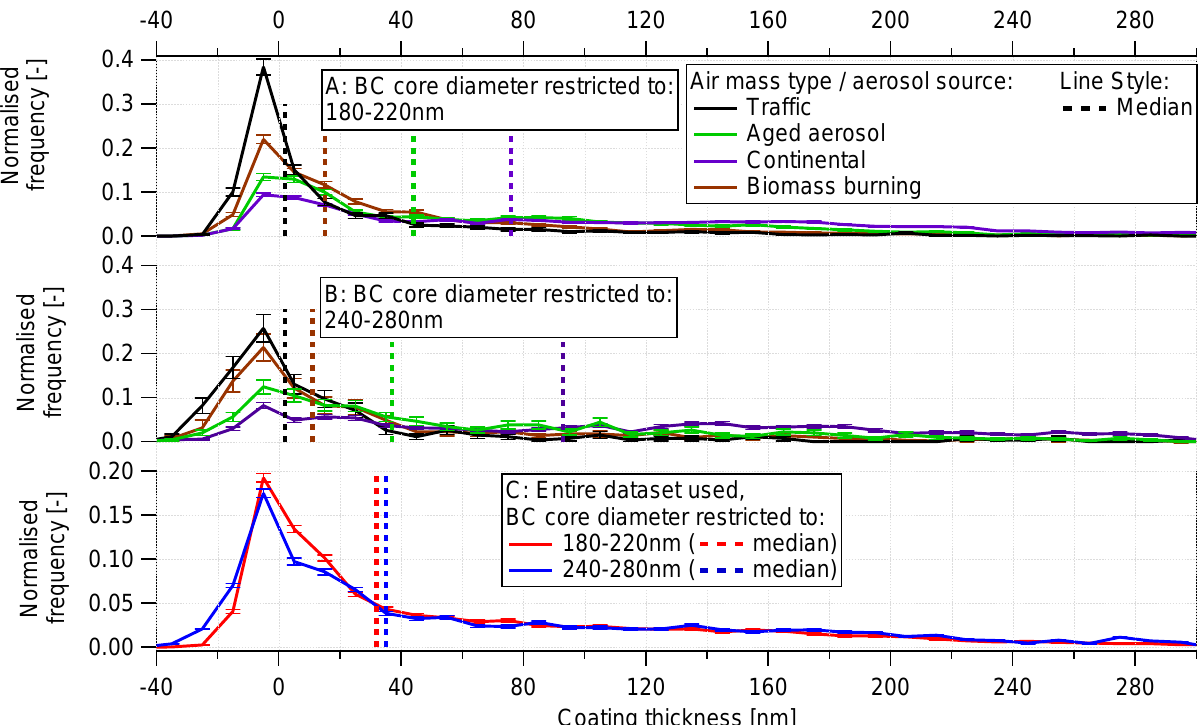
Fig. 11. Histogram (normalised by the area) of non-refractory matter coating thickness ( 1 coat ) of BC cores with a D MEV between 180– 220nm (A) and 240–280nm (B) , for different air mass types /aerosol sources. Normalised histogram of 1 coat for the entire dataset (C) . The p error bars represent the statistical significance (1/